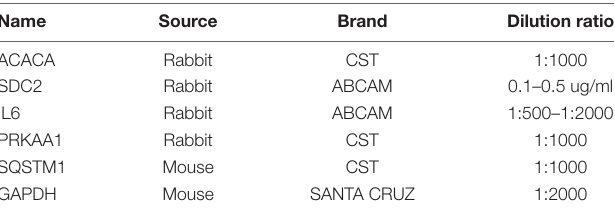
TABLE 1 | Information of primary antibodies used in western